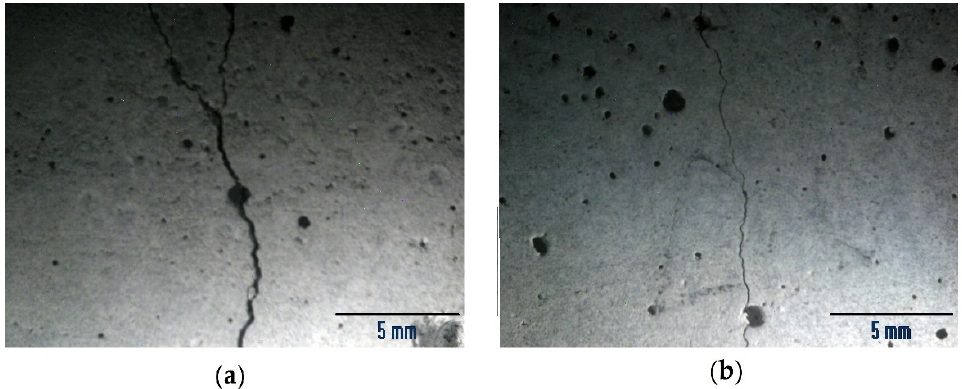
Figure 4. Stereomicroscopy images (7 × ) of samples ( a ) untreated and ( b ) treated with ALK2_AP1: a reduction in crack width is visible.